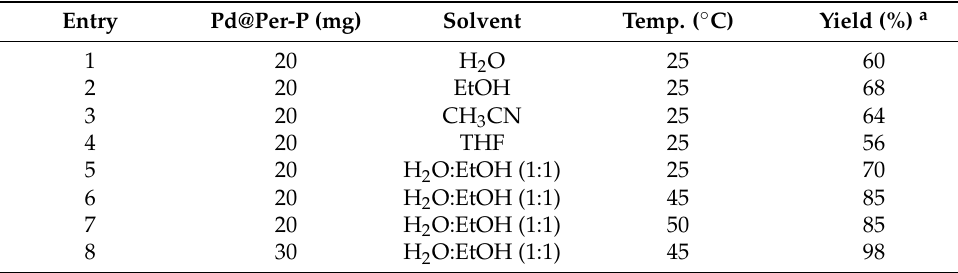
Table 1. Optimization of the experimental conditions for the hydrogenation of